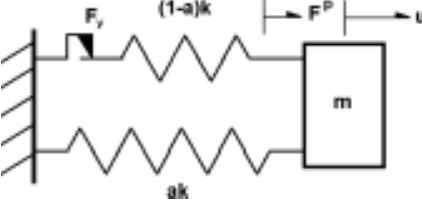
Fig. 1. An elastoplastic oscillator with kinematic